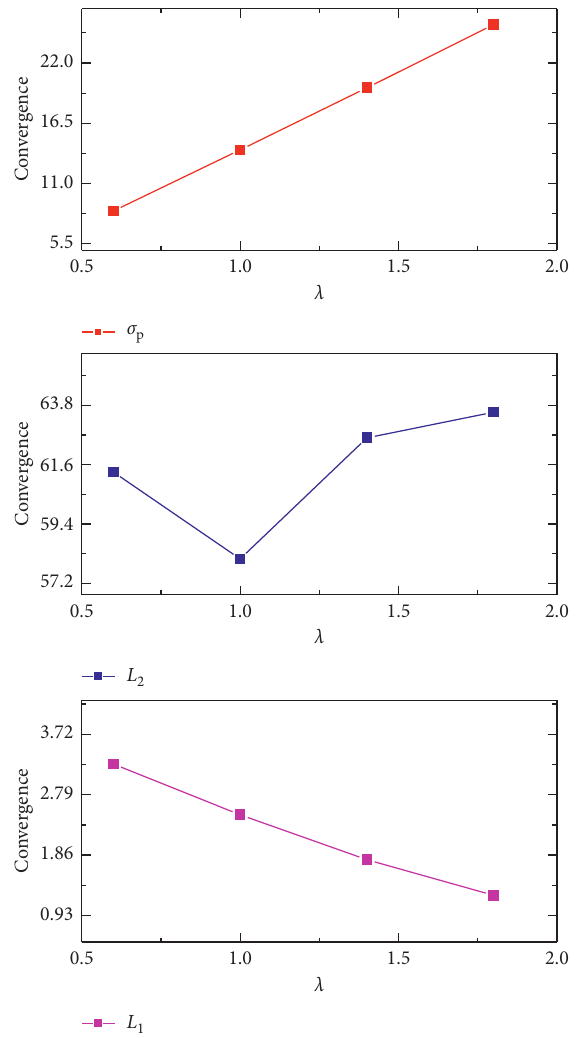
Figure 6: Variation curve of L 1 , L 2 , and σ p with lateral pressure